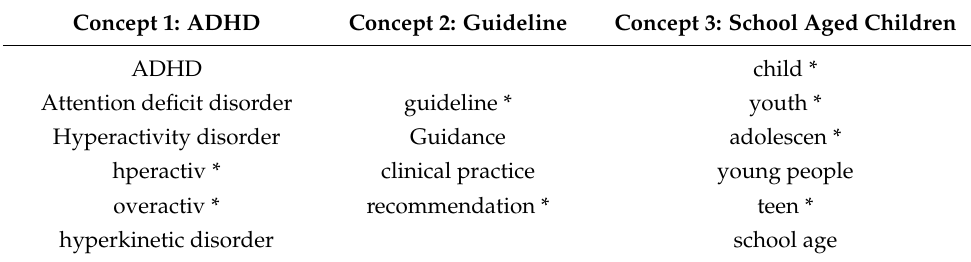
Table 1. Terms used for database searches. Concept 1: ADHD Concept 2: Guideline Concept 3: School Aged Children ADHD child * Attention deficit disorder guideline * youth * Hyperactivity disorder Guidance adolescen * hperactiv * clinical practice young people overactiv * recommendation * hyperkinetic disorder school